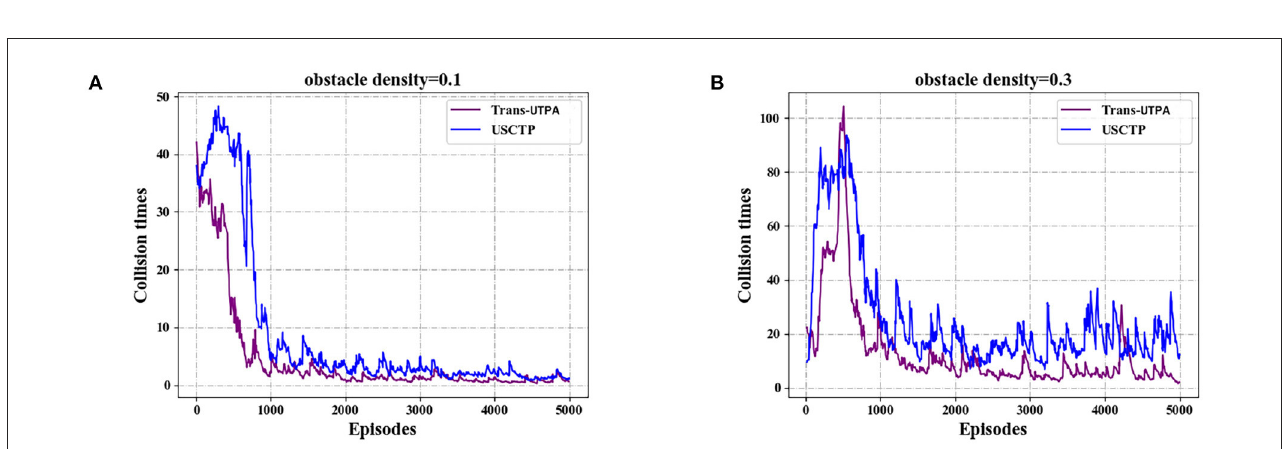
FIGURE10 Comparison experiment of collision times of UAVs. (A) Collision times with obstacle density = 0.1. (B) Collision times with obstacle density = 0.3.